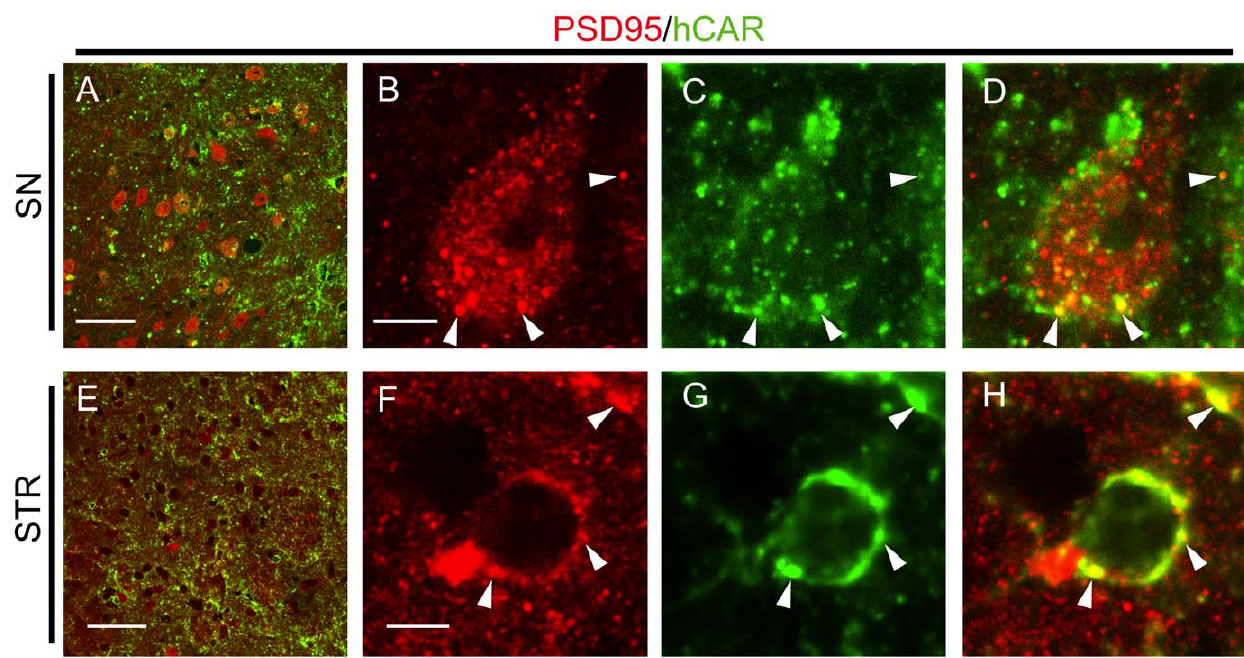
Figure 7. Transgenic hCAR localizes to post-synaptic structures. Assessing the expression pattern of exogenous hCAR in the SN and STR of transgenic animals, we found co-localization with the post-synaptic density marker PSD95 ( A–H, closed arrowheads indicate areas of co-localization). SN= substantia nigra, STR = striatum. Bars in A and E =50 m m, bars in B and F =5 m m.